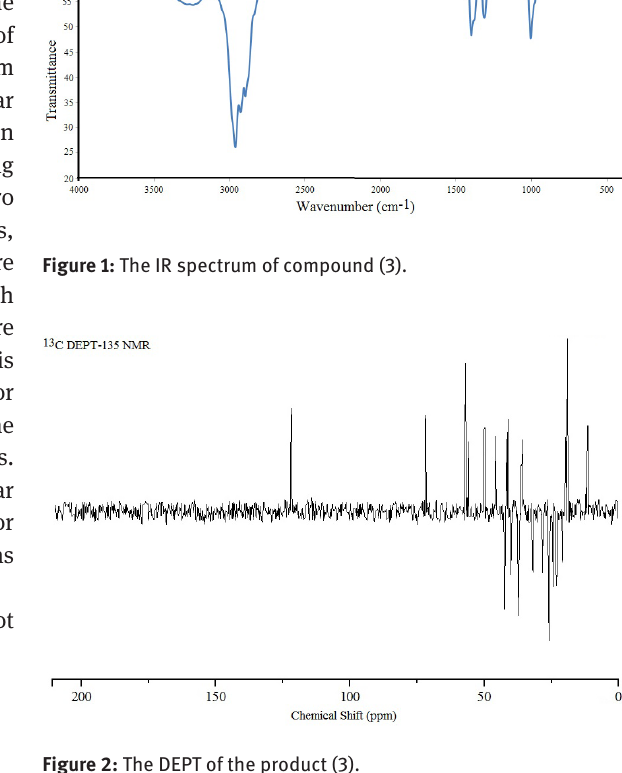
Figure 2: The DEPT of the product